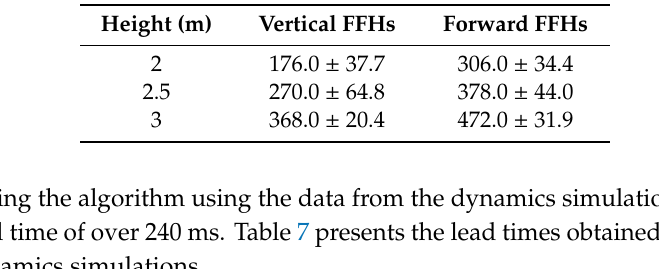
Table 6. Lead times (ms) during various motions in the mannequin experiments.